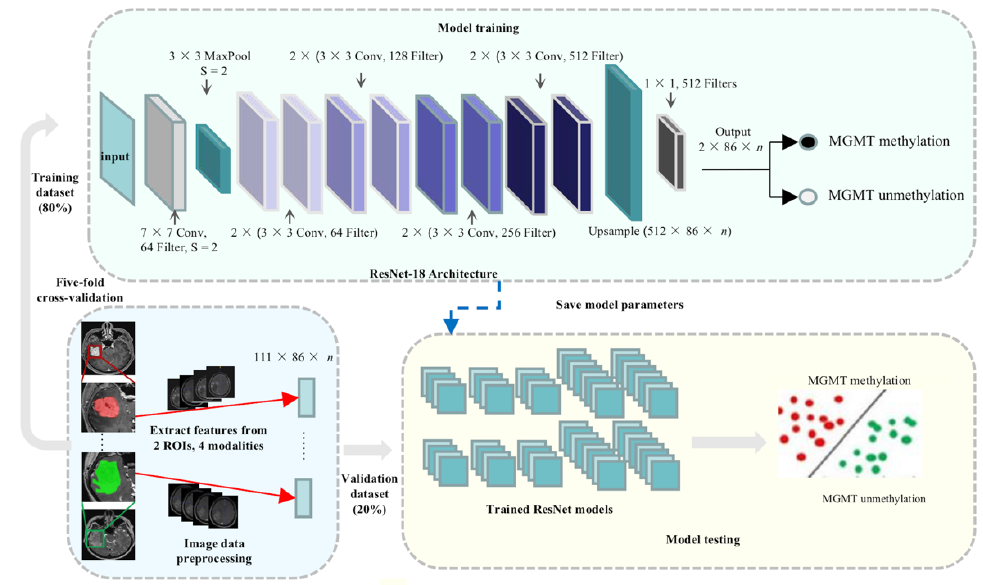
Figure 3. Structure of the deep learning model. Residual Networks extract features from 2 ROIs of 4 sequences were developed and evaluated with five-fold cross-validation, where in each fold, the dataset was randomly divided into training (80%) and validation (20%) cohorts.